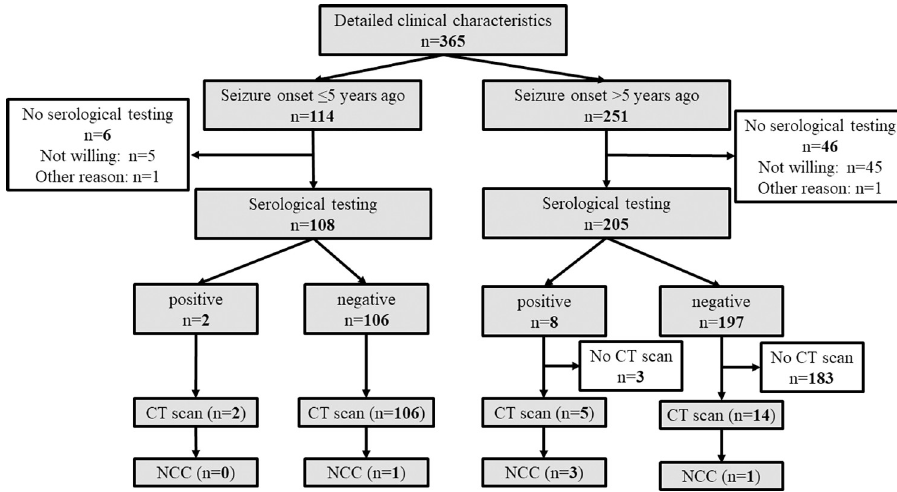
Fig 7. Flowchart of the people with epilepsy with detailed